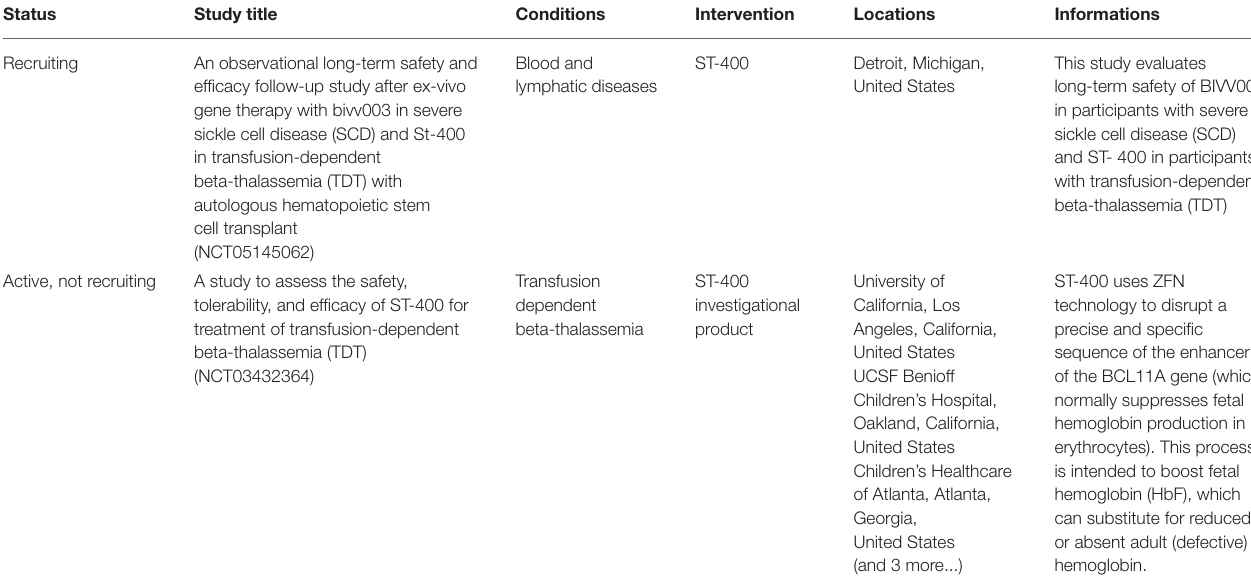
TABLE 1 | Clinical trials using the ZFN-mediated technology